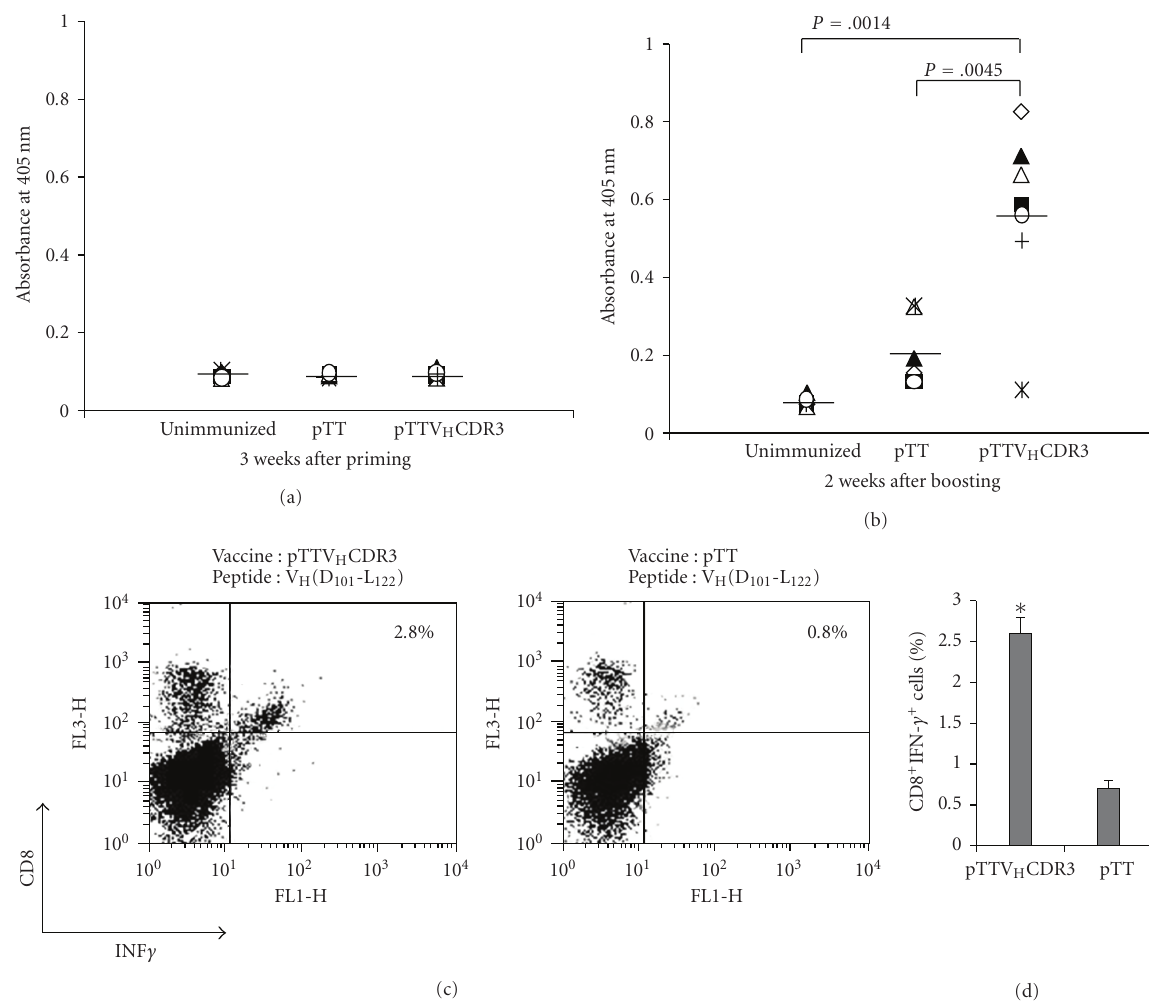
Figure 2: Immune responses elicited after pTTV H CDR3 and pTT immunizations. Humoral immunity was assayed by ELISA for mice sera V H peptide (D 101 -L- 122 ) reactive antibodies 3 weeks after priming (a) and 2 weeks after boosting. (b) Unimmunized mice represent the control group. Each marker indicates a value from a single mouse; group means are represented by a horizontal bar. Experimental groups (pTTV H CDR3 group, n = 7; control groups, n = 6) were compared by unpaired, two-tailed t -test. (c) The frequency of IFN- γ -positive CD8 + T cells was assessed ex vivo by intracellular cytokine staining. Splenic lymphocytes were harvested 1 week after booster injection, stimulated with V H peptide (D 101 -L- 122 ), and assayed for IFN- γ production on gated T lymphocytes. Representative flow cytometric plots from pooled mice (3 animals/experimental groups) splenocytes are shown. Numbers in FACS plots refer to CD8 + IFN- γ + cells as a percentage of the total T cells population. (d) Data were pooled from two identical independent experiments to indicate the mean percentage of CD8 + T cells producing IFN- γ in response to V H peptide. An X 2 test for the comparison of the two proportions, expressed as a percentage, was performed. Error bars: SEM. ( ∗ ) denotes a statistically significant value ( P < .0001).